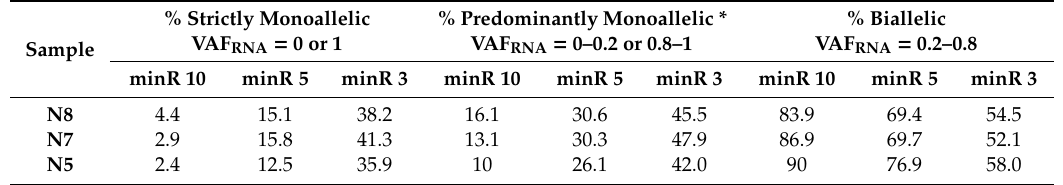
Table 2. Percent of mono- and bi-allelic expression of SNVs covered with di ff erent required minimum counts of sequencing reads. *Predominantly monoallelic expression is inclusive of strict monoallelic